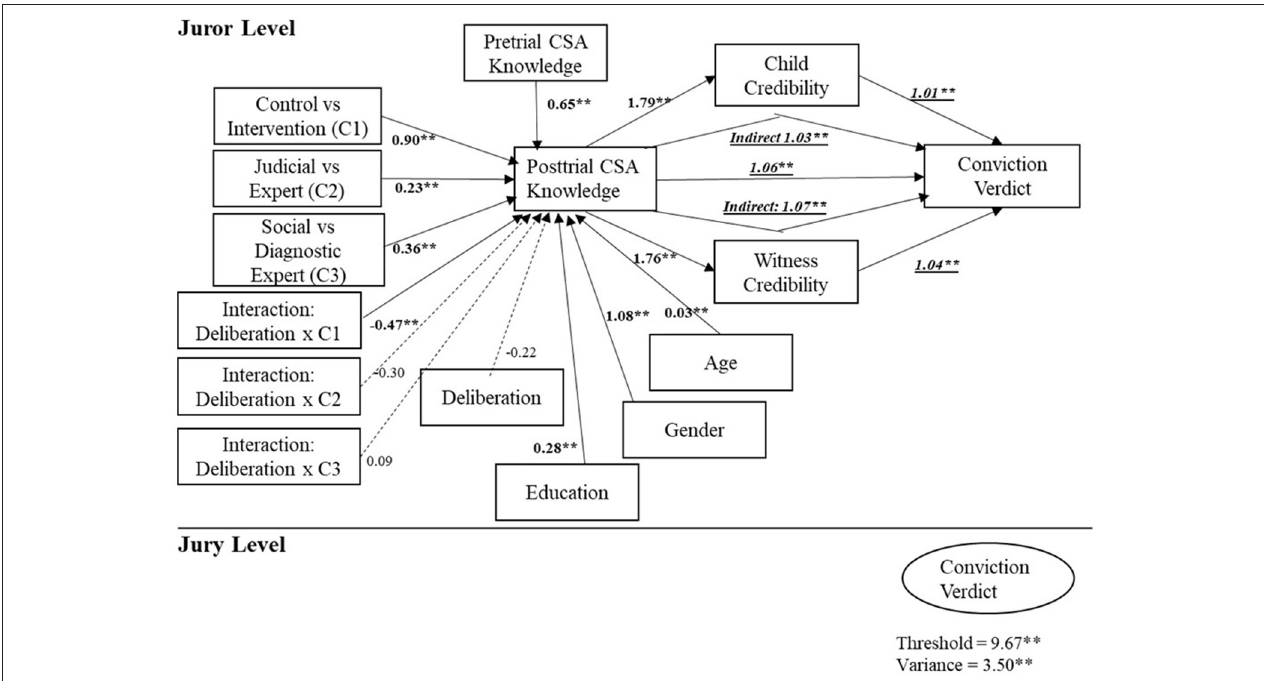
FIGURE 3 | Multilevel structural equation modeling: unstandardized path coefficients (bs and Odds ratios in Model 7) for victim and witness credibility mediators of the impact of CSA knowledge on guilty